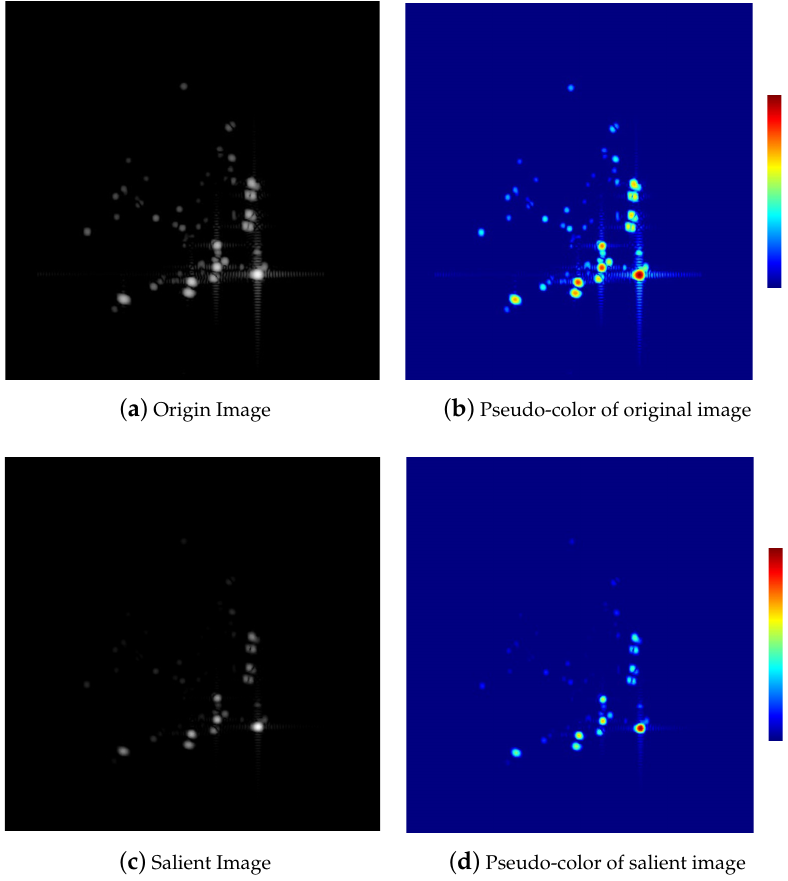
Figure 6. Enhancing salient points in a simulated SAR image. ( a ) A simulated image with a clean background and ( b ) its corresponding pseudo-color image. ( c ) The result after salient point enhancement and ( d ) the corresponding pseudo-color